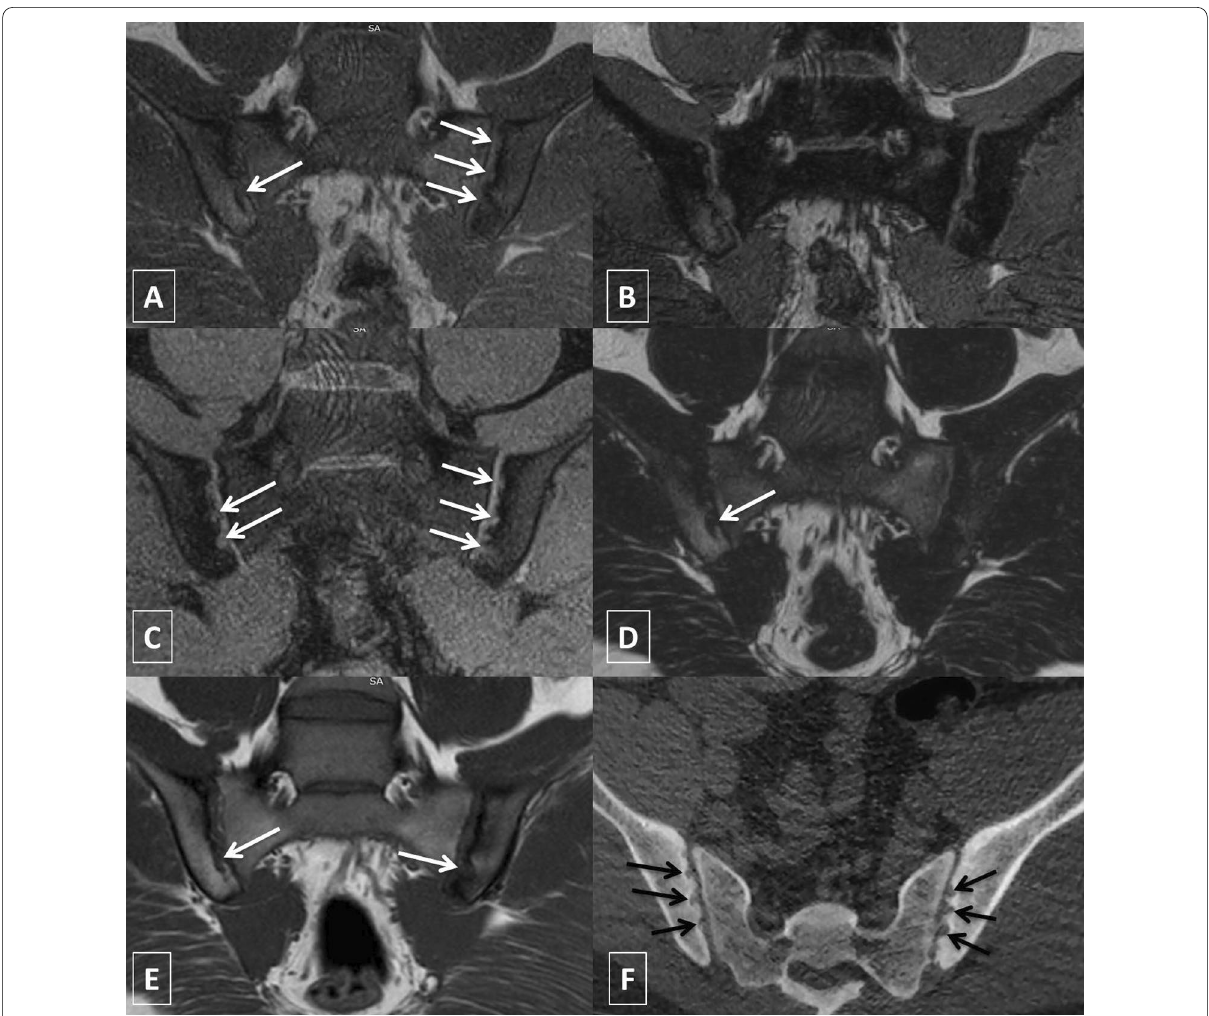
Fig. 4 Eighteen years male patient with four years history of AS and low back pain, ASDAS was very high images ( A – D ) show multiple bilateral iliac erosions with sclerotic margins (white arrows), some have T1 hyperintensity consistent with backfills, note how T1WI ( E ) shows fewer lesions when compared with Dixon images and CT ( F ) (black